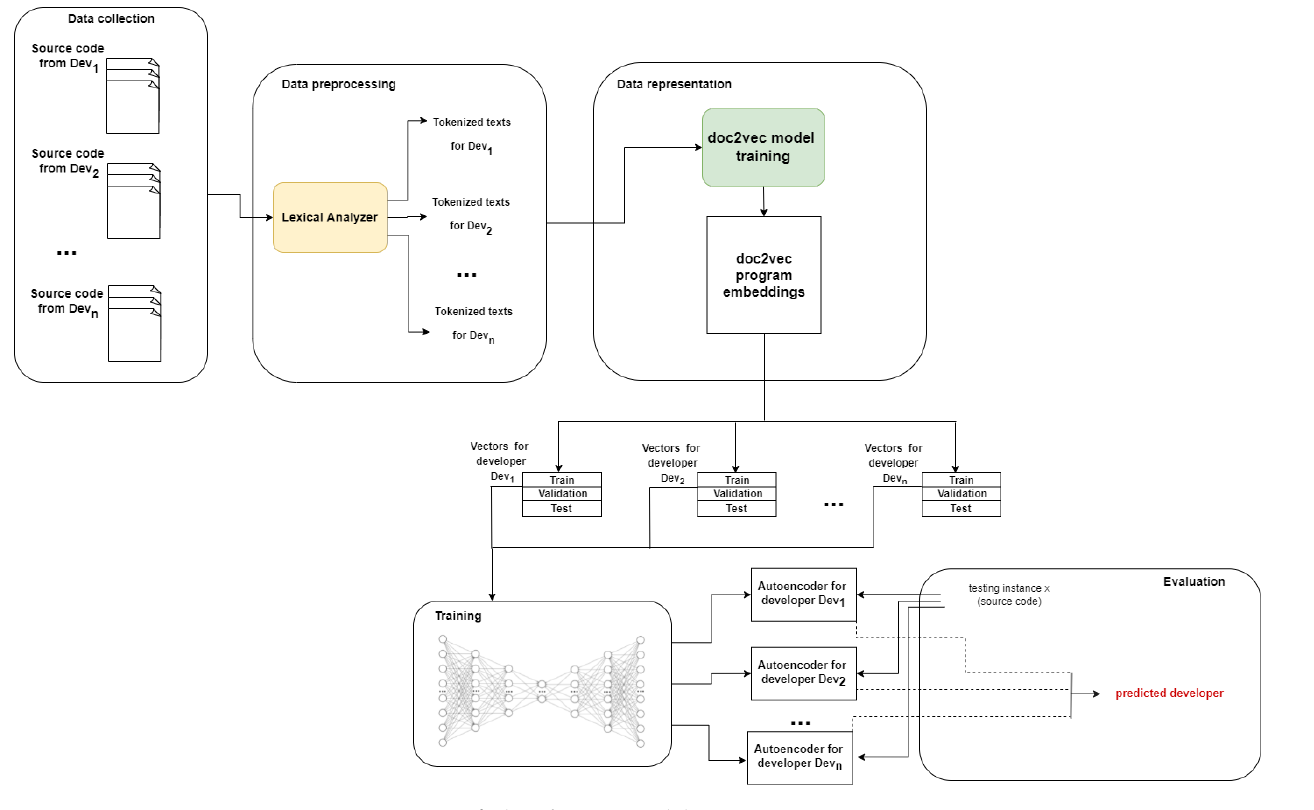
Figure 1. AutoSoft classification